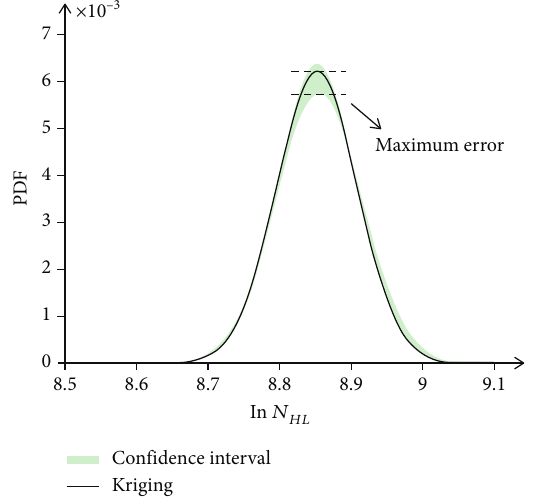
Figure 9: Comparison of MCS and Kriging (turbine blade). Table 6: Turbine blade fatigue life